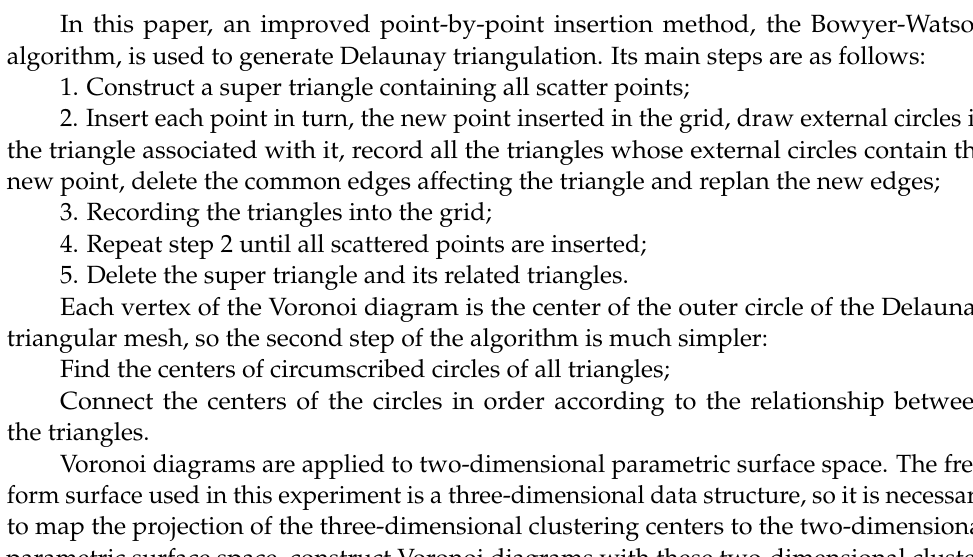
Figure 7. Preliminary division of the surface based on curvature, □ stands for convex area, ▽ stands for saddle area, ◇ stands for concave area.